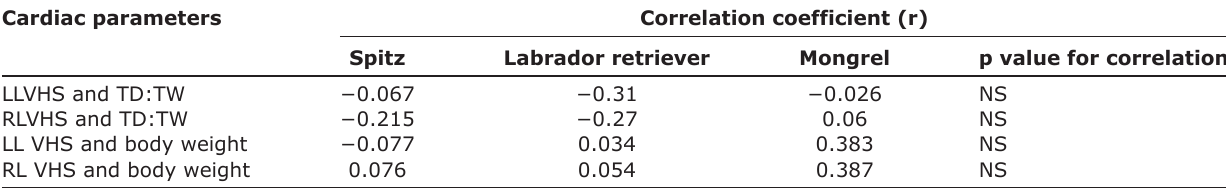
Table-6: Pearson correlation coefficients of LL and RL VHS to TD to TW ratio and body weight in Spitz, Labrador retriever and Mongrel dogs. Cardiac